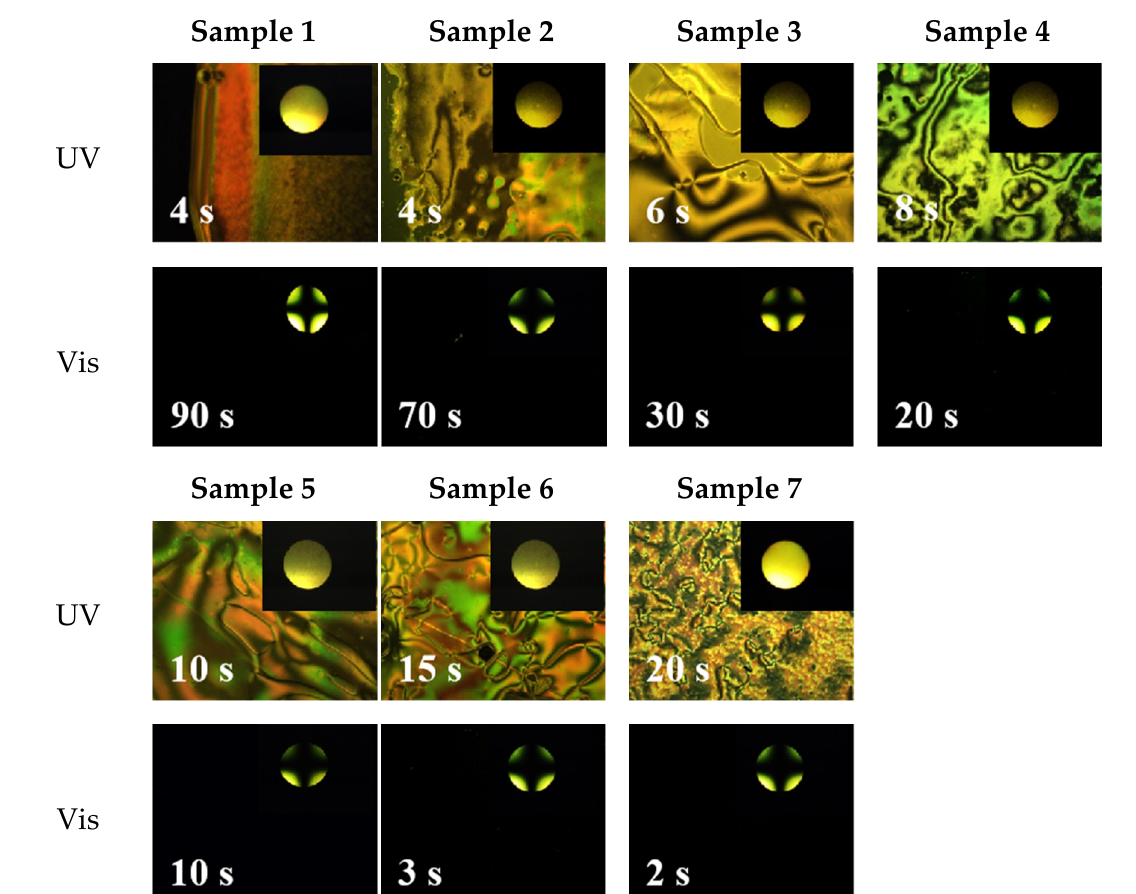
Figure 8. POM of the M1-doped 5CB mixtures with different mass fractions irradiated by 365 nm and 470 nm light for different times.